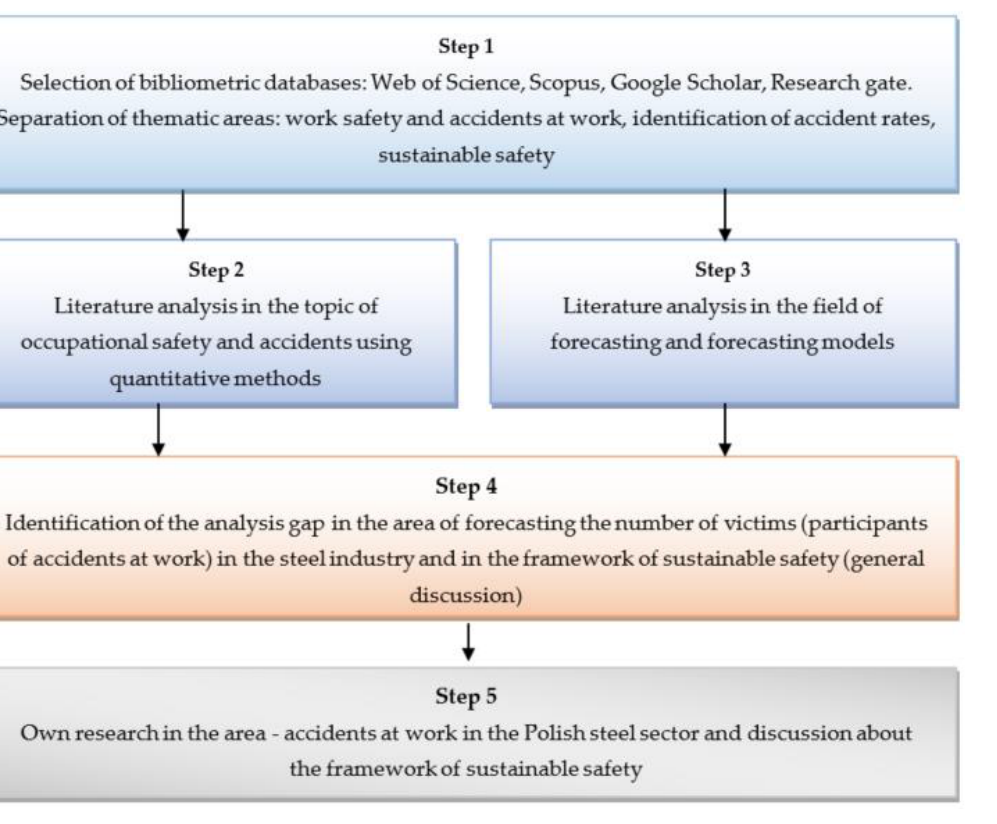
Figure 1. From literature retrieval process (own study).